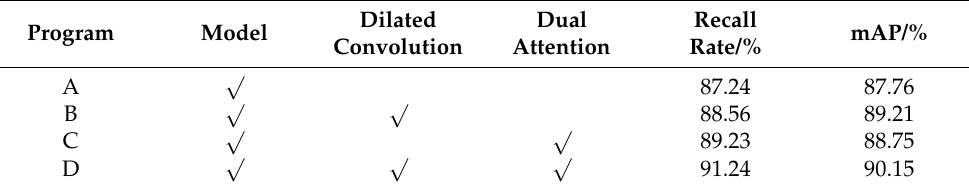
Table 5. Ablation experiment.